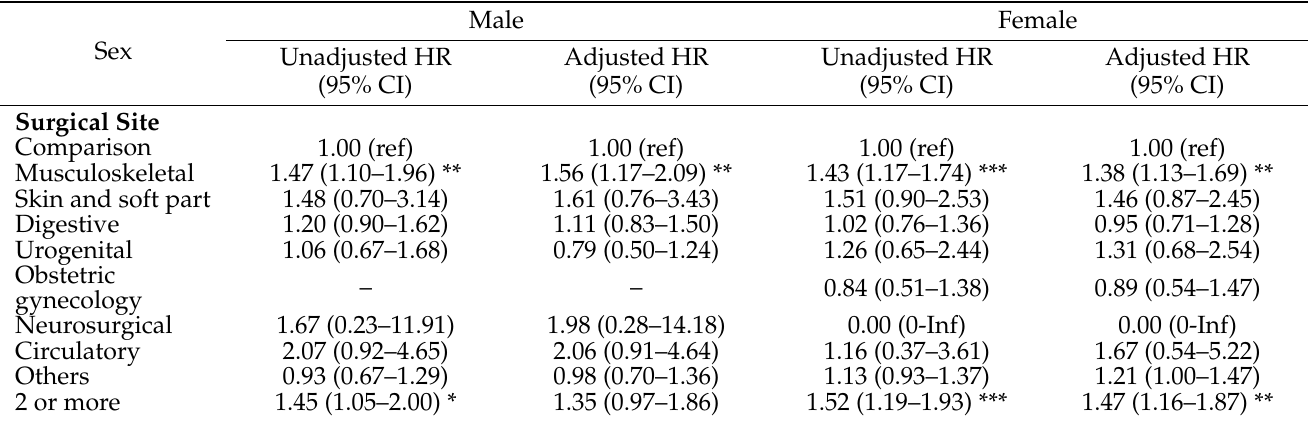
Table A4. Hazard ratios of all-cause dementia according to the sex among surgical sites.